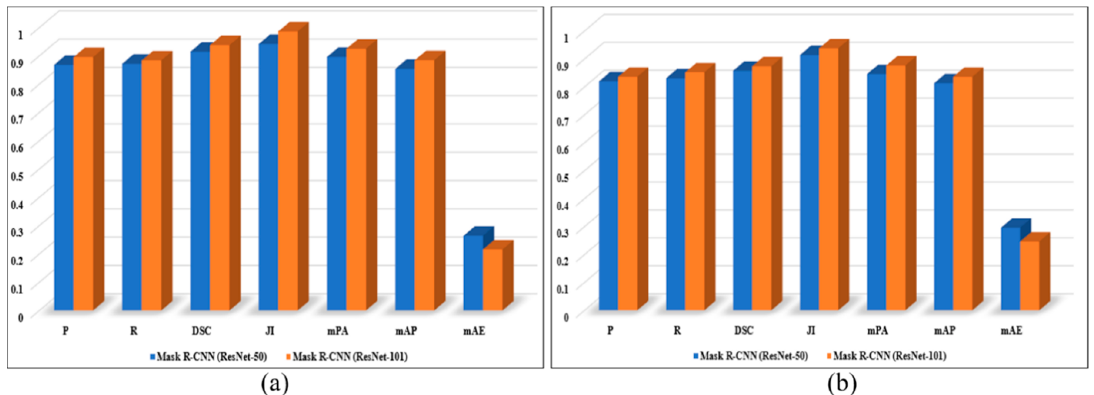
Figure 6. Sensors 2020 , 20 , x FOR PEER REVIEW